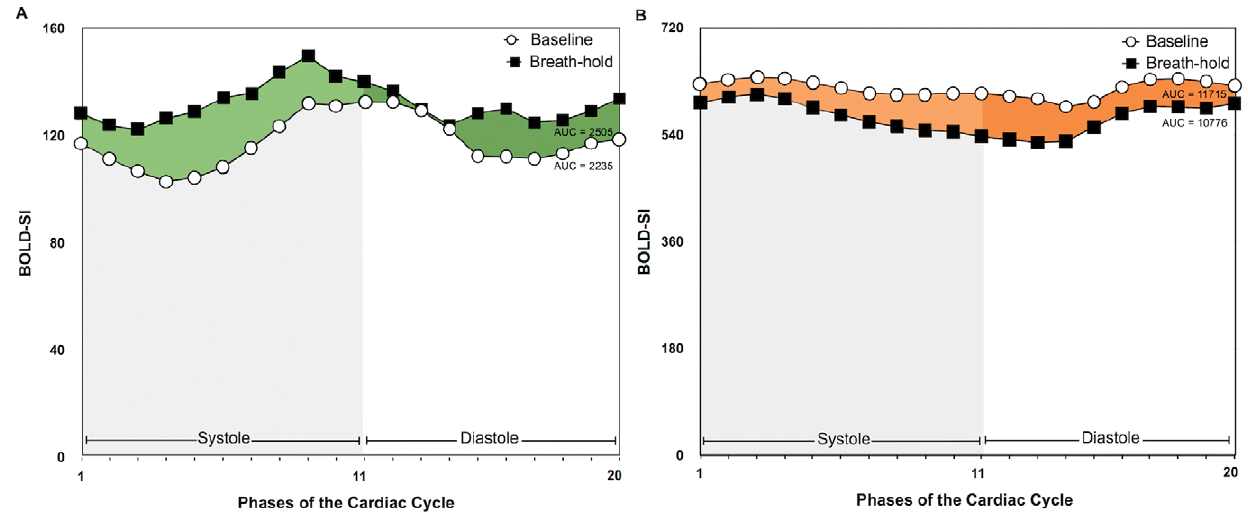
Figure 1. Myocardial and blood pool SI throughout the cardiac cycle. The area under the curve was calculated from the absolute BOLD-SI values of the 20 phases of the cardiac cycle from images obtained at the start and at the end of a breath-hold of both the myocardium ( A ) and blood pool ( B ) of one subject.